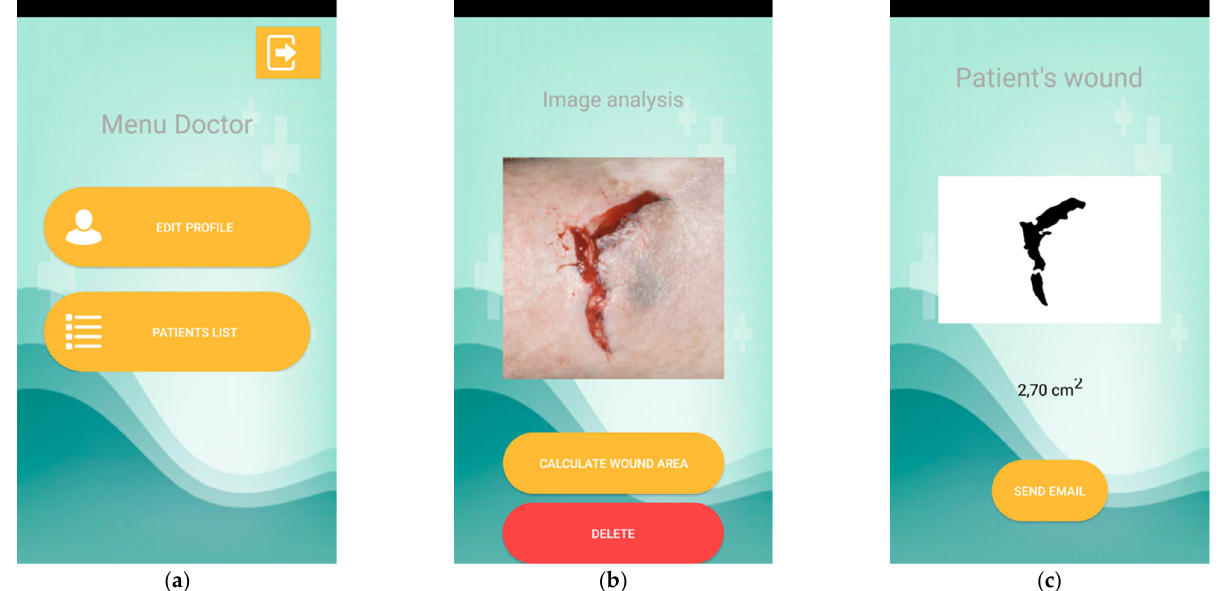
Figure 8. Doctor’s actions. Figure ( a ) shows the doctor’s menu. Figure ( b ) shows the details of a selected image in the list. Figure ( c ) shows the results of the wound analysis.